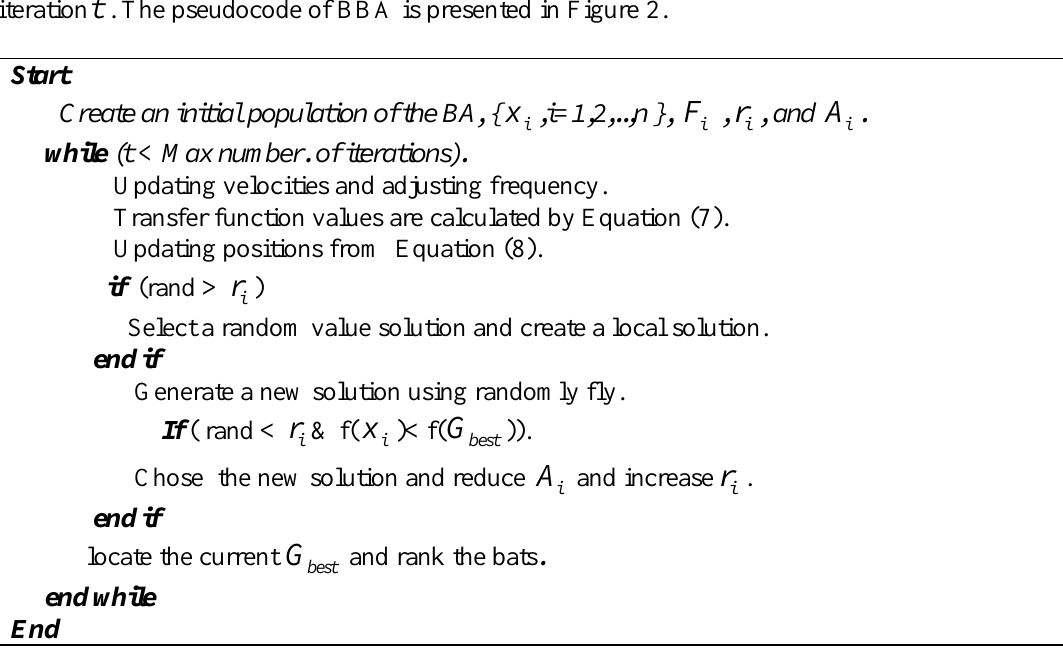
Figure 2. The pseudocode of the